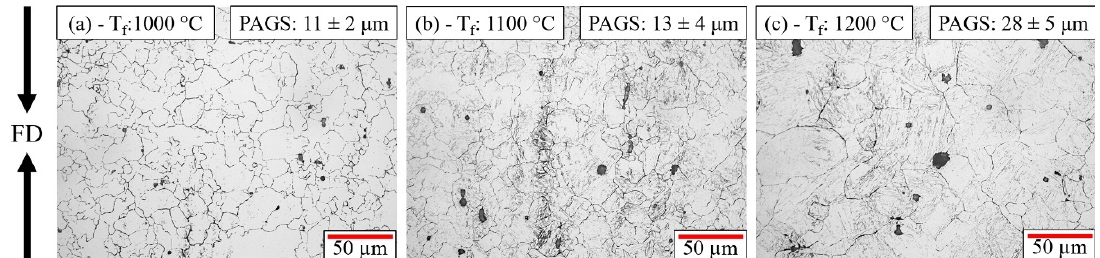
Figure 4. Optical microscopy of the PAGS after hot deformation with 60% of reduction at ( a ) 1000 °C; ( b ) 1100 °C; and ( c ) 1000 °C T f , forging temperature; FD, forging direction.